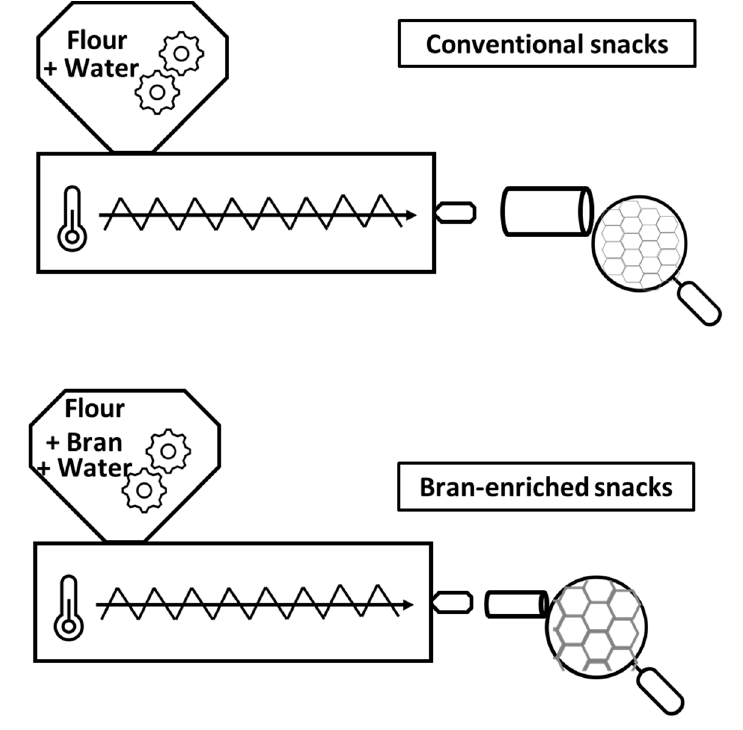
Figure 2. Schematic diagrams illustrating differences in shape and appearance between extruded snacks from bran-containing raw materials in comparison to conventional feed mixes based on refined flours or starches.